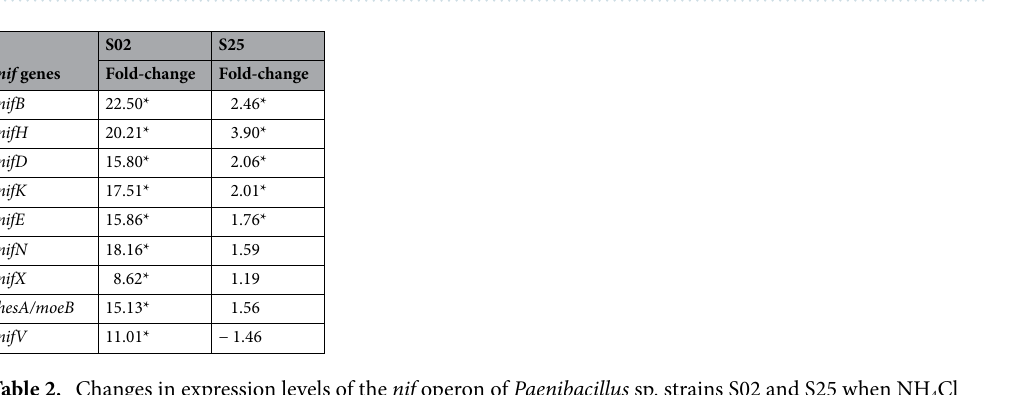
Figure 3. PCA plots of transcriptome profiles of Paenibacillus sp. strains S02 (left) and S25 (right) when grown in media with nitrogen (N) and without nitrogen (N-free) in the N-fixation activity assay. Percentage variance explained by each axis are given in brackets. Distinctive clusters indicate that the presence/absence of a nitrogen source (NH 4 Cl) in the media changed the transcriptome profiles of both strains.